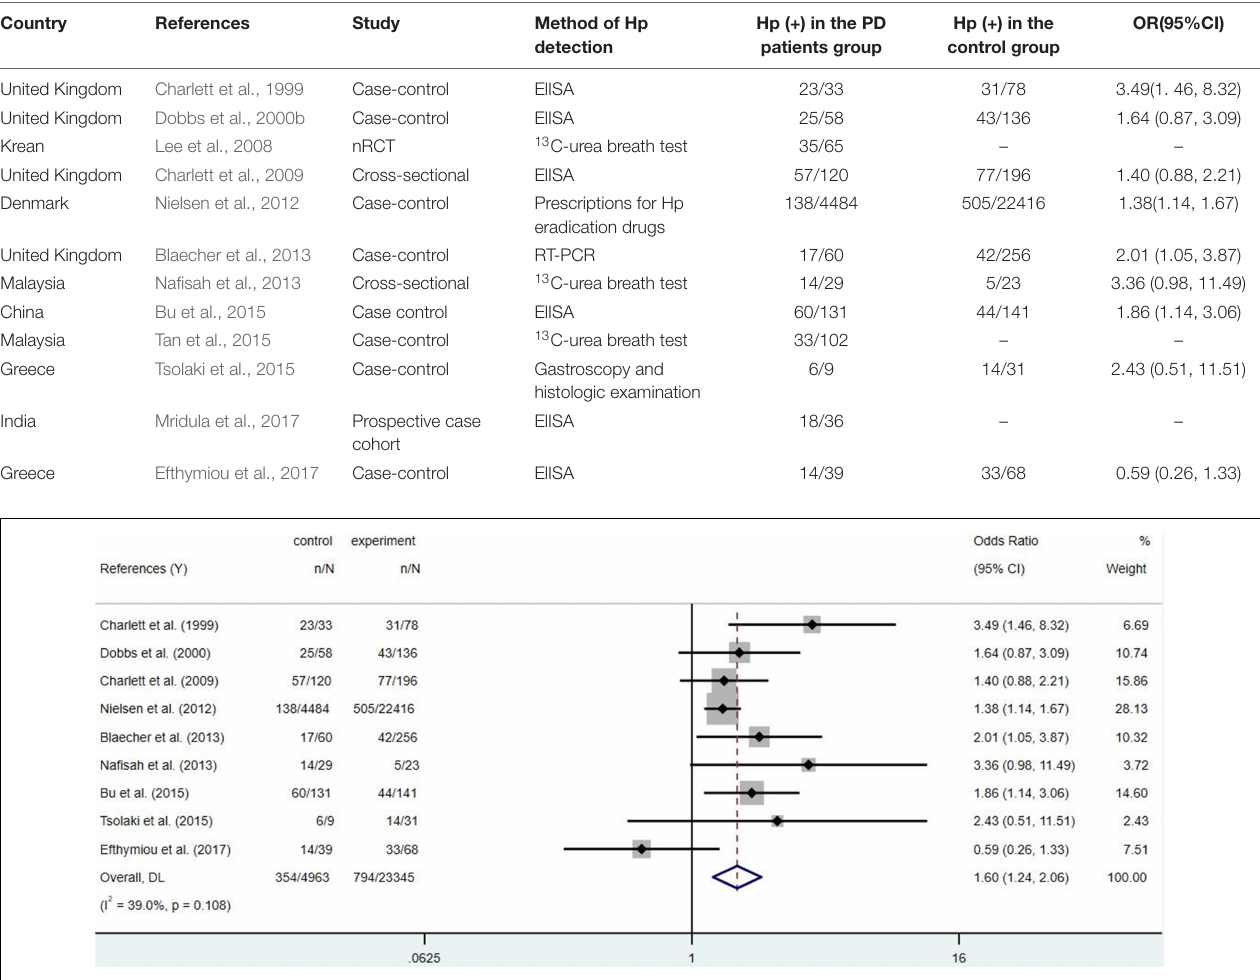
TABLE 3 | Effect of radical cure of Helicobacter pylori on Parkinson’s disease (PD). Country